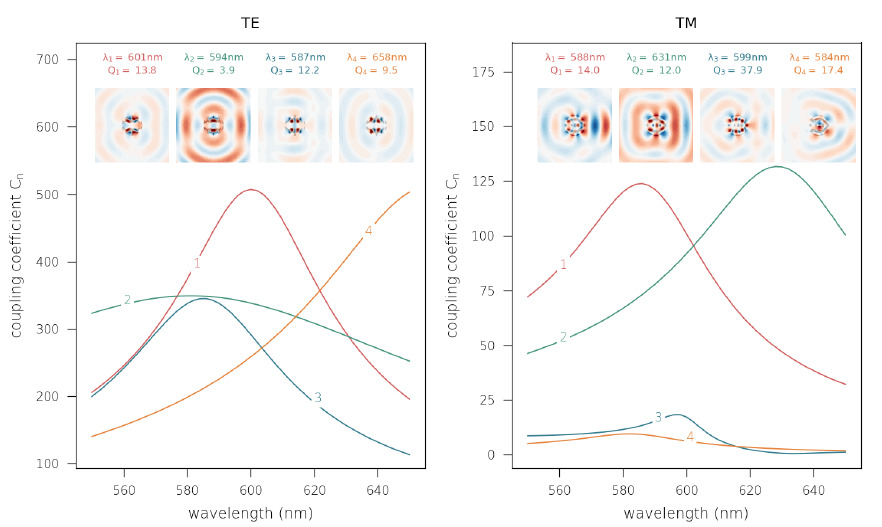
Figure 2. Modal analysis of optimized supperscatterers for TE (left panel) and TM (right panel) polarization. The curves are the coupling coefficients as a function of incident wavelength for the four dominant eigenmodes (those with the highest | C n | at λ = 600 nm). The insets show the real part of the eigenfield v n for the corresponding QNMs, its resonant wavelength λ n = 2 π /Re ( k n ) , and quality factor Q n = Re ( k n ) /2Im ( k n )